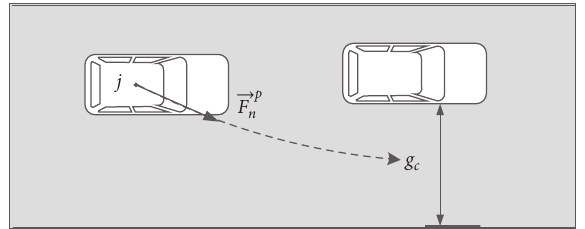
Figure 3: Passable-gap force of vehicles at the intersection with a straddling work